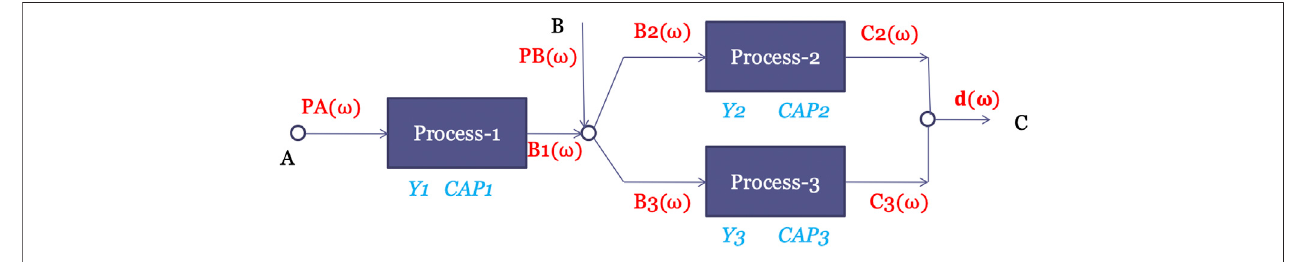
FIGURE 3 | Superstructure for the process network